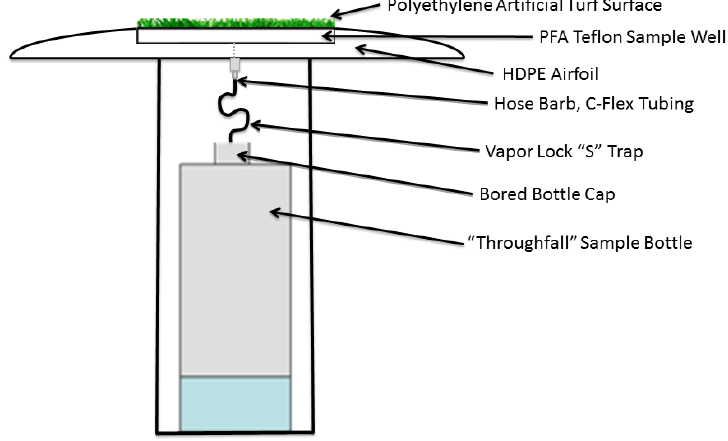
Figure 1. Schematic of Artificial Turf Surrogate Surface (ATSS) sampler.